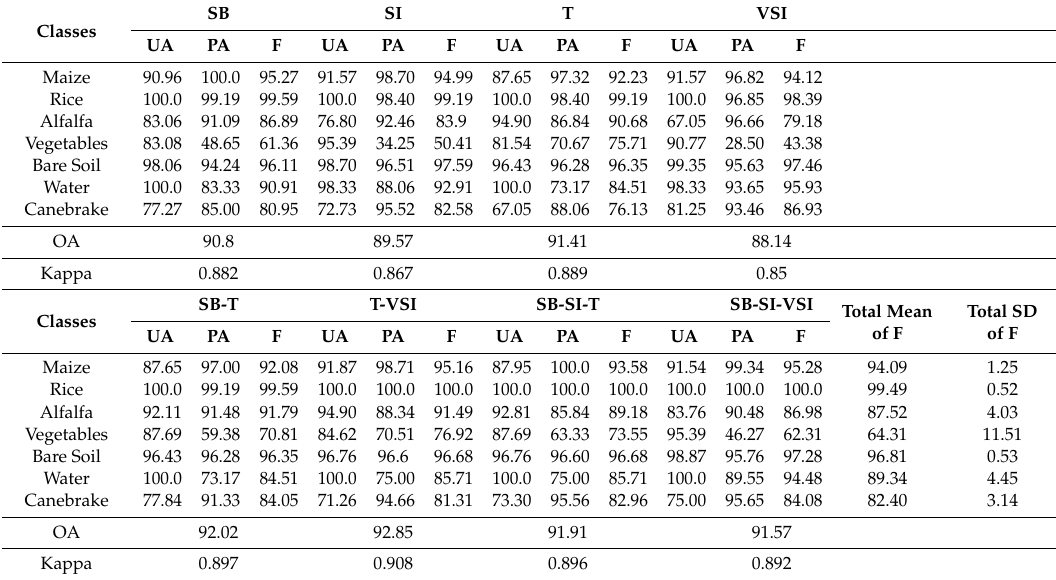
Abbreviations: Spectral bands (SB), spectral index (SI), texture (T), variation of spectral index (VSI), user’s accuracy (UA, %), producer’s accuracy (PA, %), F-score (F, %), overall accuracy (OA, %), Kappa coe ffi cient (Kappa), and standard deviation